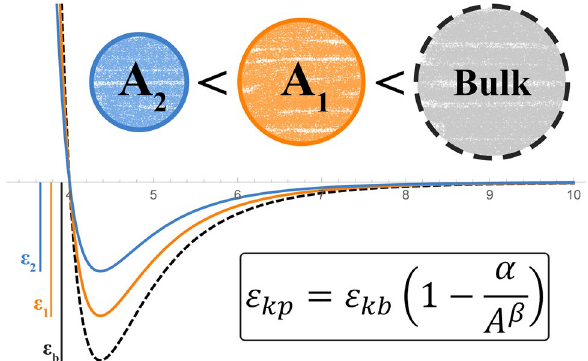
Figure 10. Depiction of pore-dependent energy